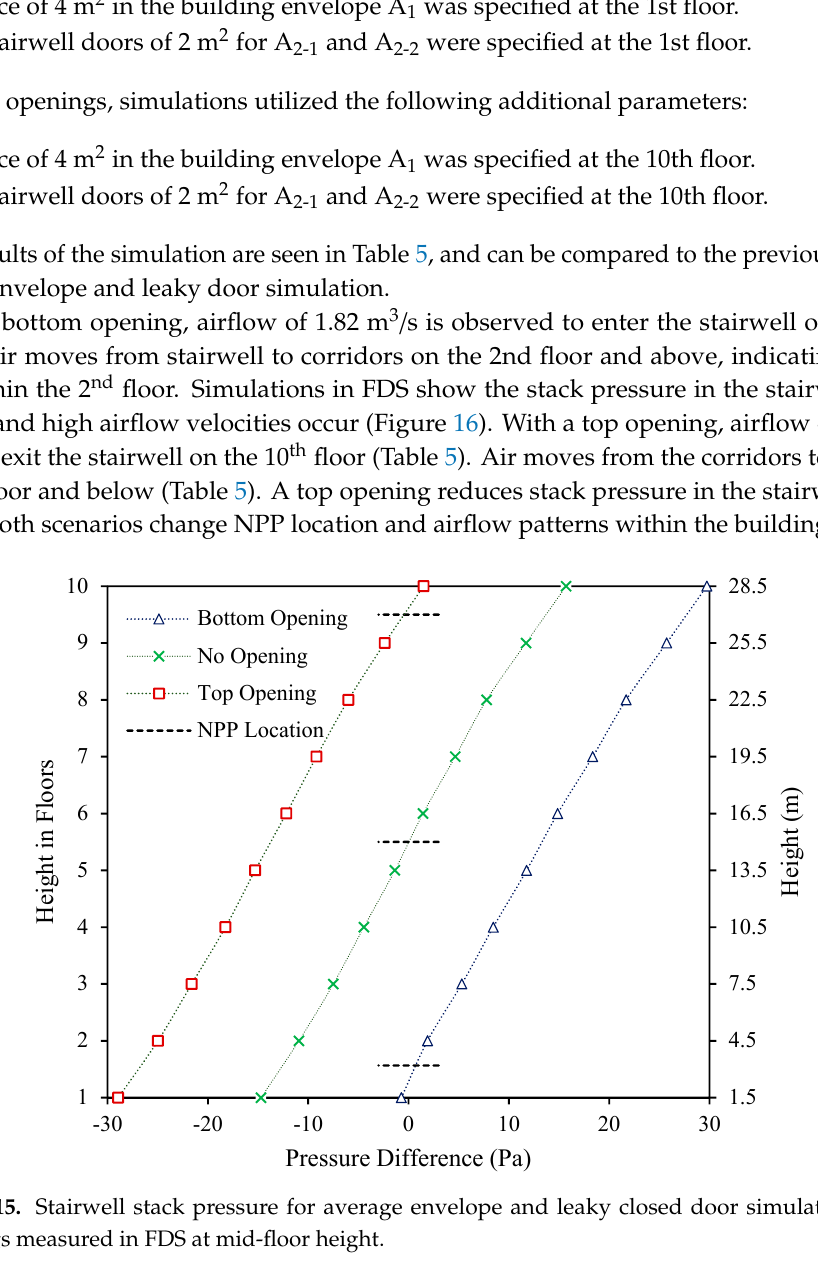
Figure 15. Stairwell stack pressure for average envelope and leaky closed door simulations with openings measured in FDS at mid-floor height.